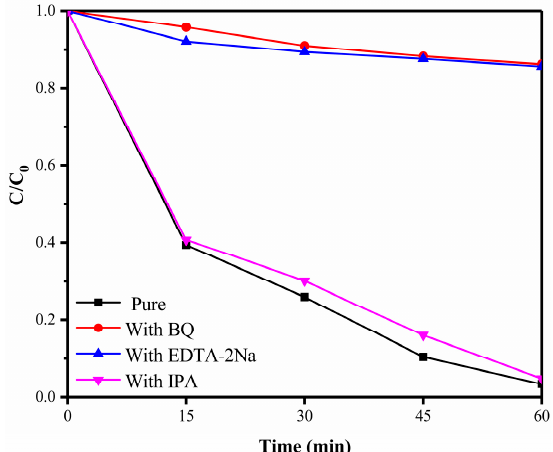
Figure 15. Active species capture experiments of 1% S-doped Bi 2 MoO 6 sample.